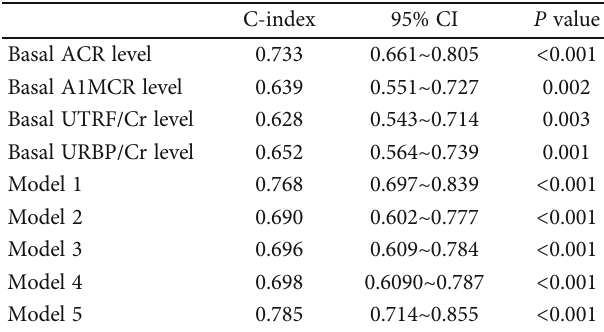
Table 3: The C-indexes of di ff erent models for prediction of the development risk of renal dysfunction during the